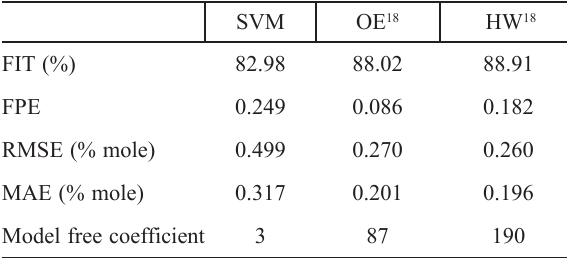
Table 11 – 2-MP content model